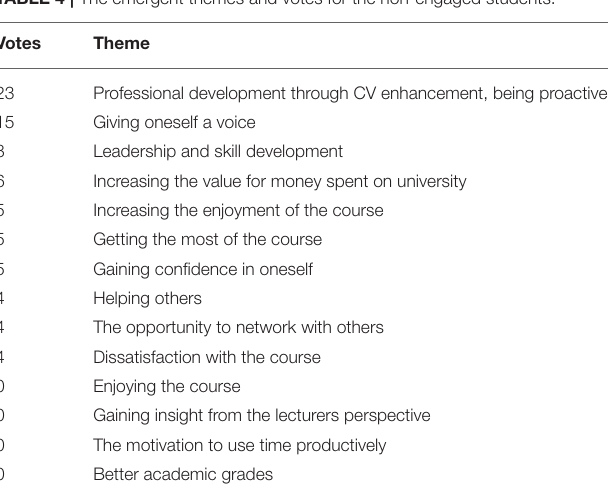
TABLE 4 | The emergent themes and votes for the non-engaged students.